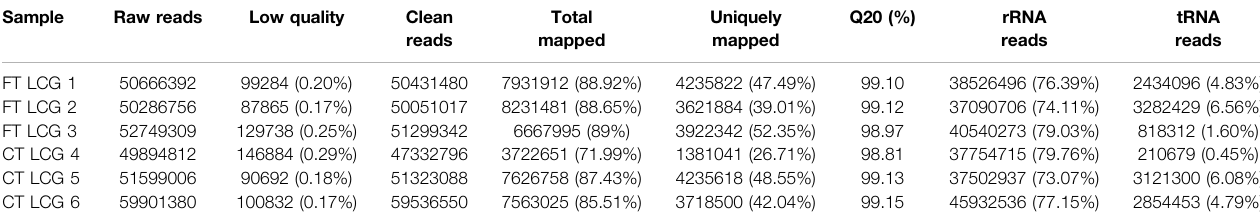
FTLCG1isthe fi neLiaoningCashmereGoatNo. 1 sample,FTLCG2isthe fi neLiaoningCashmereGoatNo. 2 sample,FTLCG3isthe fi neLiaoningCashmere GoatNo.3 sample,CT LCG4isthe coarseLiaoningCashmereGoatNo. 4sample,CTLCG5 isthecoarseLiaoningCashmereGoatNo. 5sample,andCTLCG6is thecoarseLiaoningCashmereGoatNo.